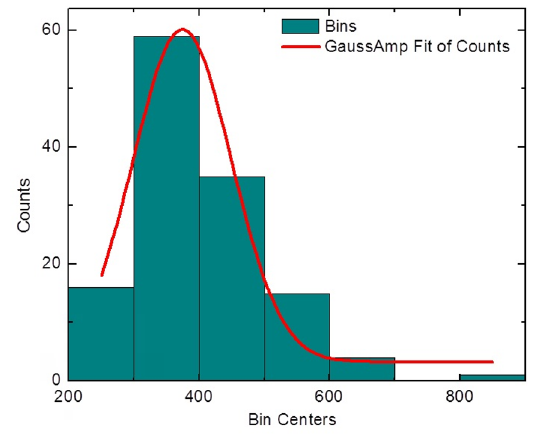
Figure 5. Determination of the mean grain size by the AGI method from the image of figure 4.